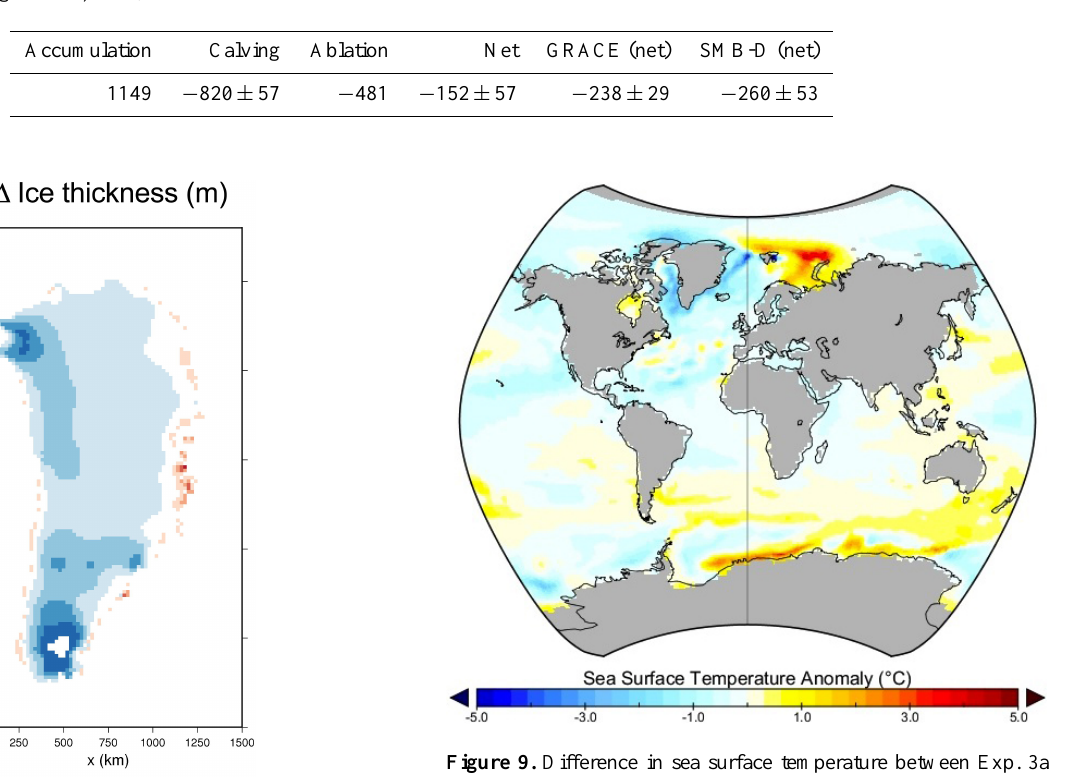
Table 3. Mass balance of the Greenland Ice Sheet, all values in Gta − 1 . Model values were taken from Experiment 1b as means over the last 1000 of 10000 model years. For calving and net balance we also present the standard deviation as derived from the simulation. For accumulation and ablation these would be meaningless as the last 1000 model years are forced with the same atmospheric fields (see Table 2). Nevertheless, we can estimate the standard deviation over the whole 10000 model years and get ± 71Gta − 1 for accumulation and ± 45Gta − 1 for ablation. For comparison, we also present observational data from GRACE (Sasgen et al., 2012), as well as surface mass balance (SMB) model data from RACMO (Ettema et al., 2009), in which discharge D from IceSAT (Rignot et al., 2006) is taken into account (values taken from Sasgen et al., 2012).